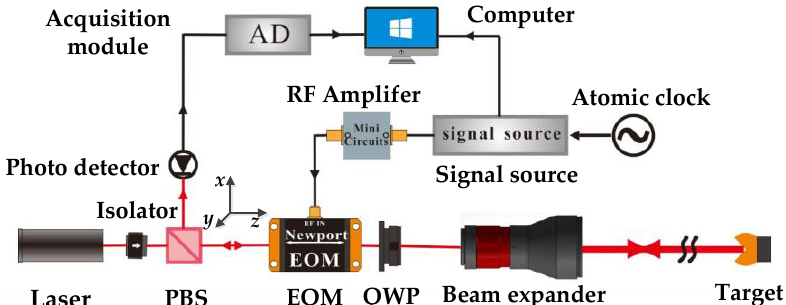
Figure 1. Schematic diagram of the polarization-modulation ranging system. EOM: electro-optic modulator; PBS: polarizing beam splitter; QWP: quarter wave plate.